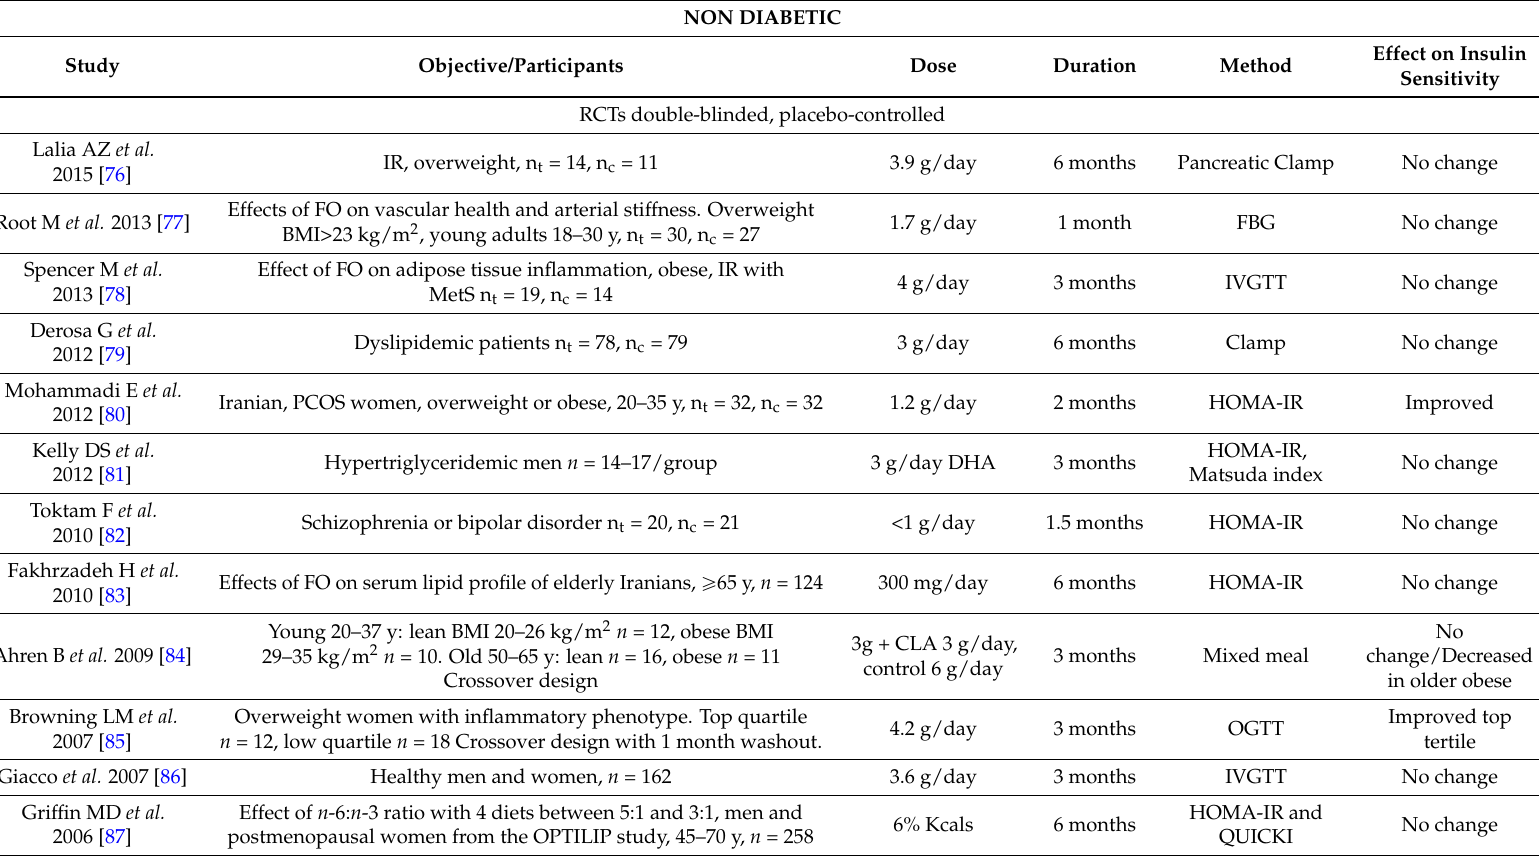
Table 1. Summary of human clinical trials in non-diabetic